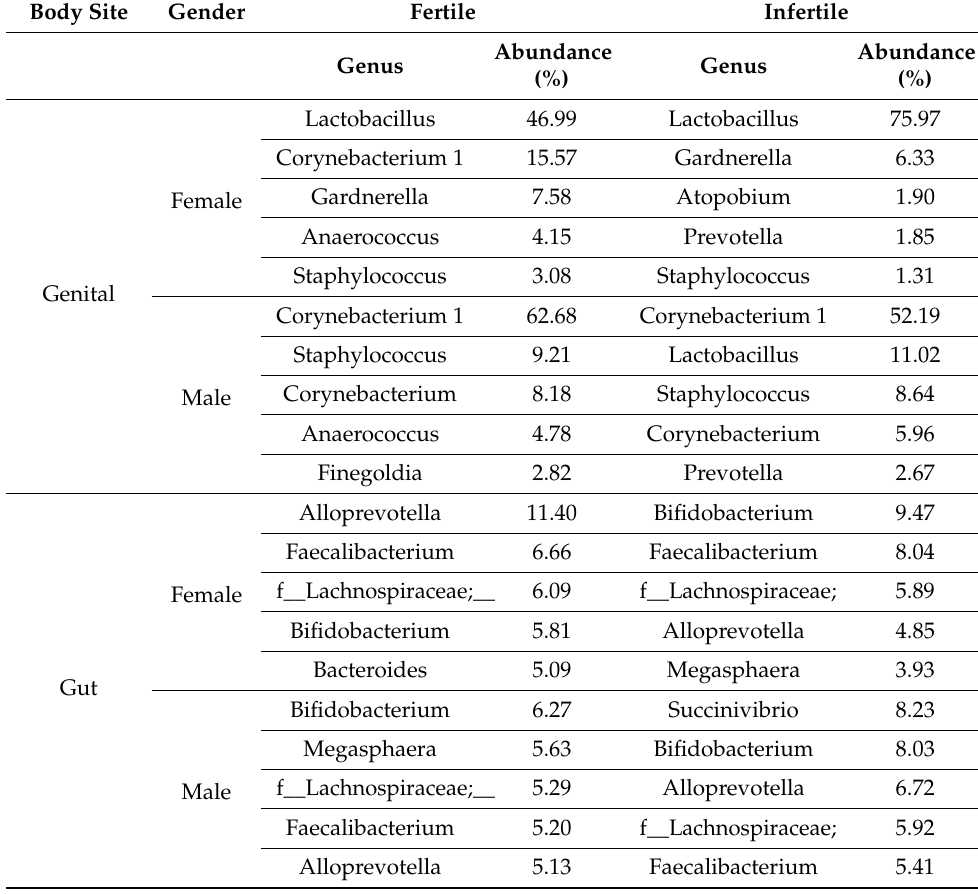
Table 2. Mean relative abundance of the top five most abundant genera in each of the eight unique possible combinations of fertility status, body site, and